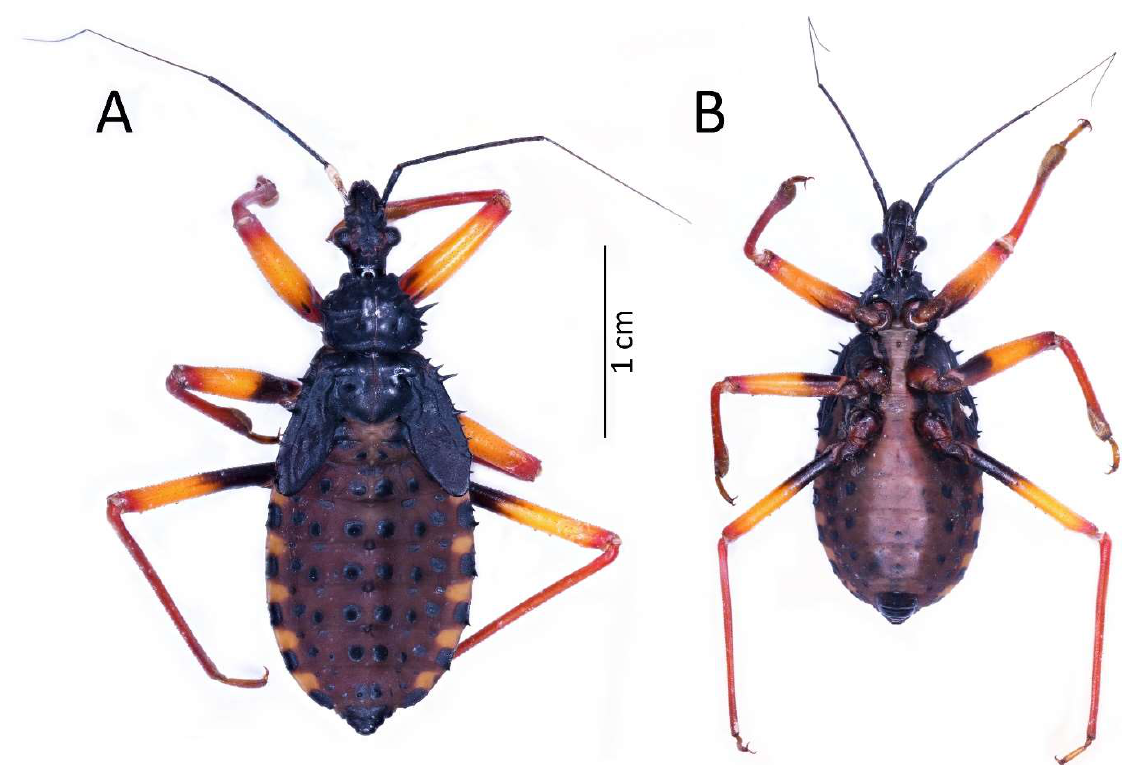
Figure 13. ( A ) Dorsal and ( B ) ventral habitus of the fifth instar of Psyttala horrida (Stål, 1865). Structure: Whole head strongly sclerotised with distinct granulation and visible; ecdysial lines black, hardly visible. Ante- and postocular part of the head with same number and placement of spine-like processes with similar length than in fourth